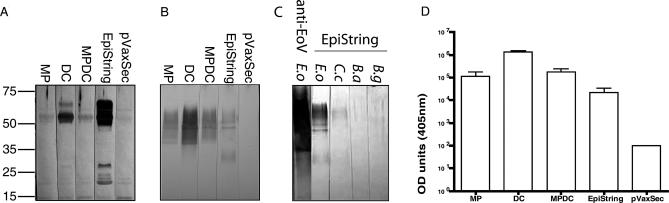
EoSVMP String Antiserum Recognizes Multiple SVMP Isoforms(A and B) Comparative reactivity on immunoblots using pooled murine antisera raised against EOC00024 domains (MP, DC, and MPDC) and EoSVMP string to
E. ocellatus venom under reduced SDS-PAGE (A) and native PAGE (B) conditions.
(C) Comparative reactivity on native PAGE immunoblots of EoSVMP string antiserum to venoms from
E. ocellatus (Eo),
C. cerastes (Cc),
B. arietans (Ba), and
B. gabonica (Bg). Cross-reactivity of rabbit antisera against
E. ocellatus venom (anti-EoV) is shown for comparison.
(D) IgG ELISA end-point titres determined by serial dilution of murine antisera. Values represent the mean dilution (± standard error of the mean) of sera equaling the titre of sera from unimmunized BALB/c mice.